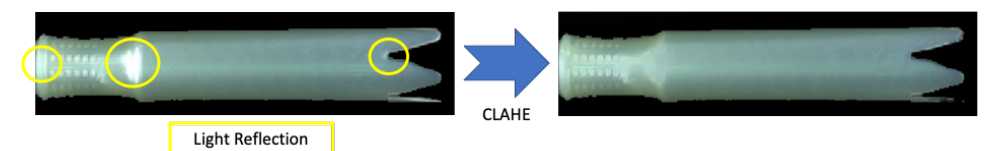
Figure 16. Diluting light reflection by Contrast Limited Adaptive Histogram Equalization. The background, such as the conveyor and blue boundary for image slicing, were occa- sionally detected as defects, which harms the accuracy of the inspection model. To improve the precision of the model, we removed the background by extracting the object’s outline using the contour technique. The result of the Background Removal (BR) is presented in Figure 17.